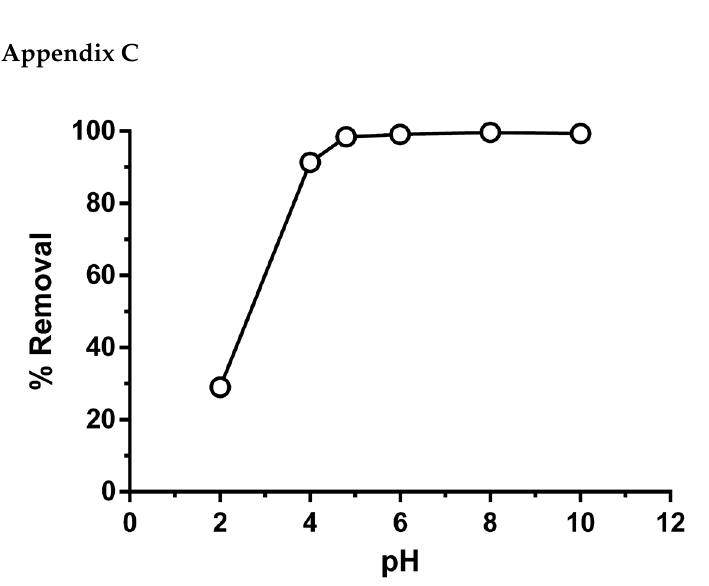
Figure A1. Effect of pH on Cu(II) ions removal. The initial concentration was 24 mg · L − 1 in each case.